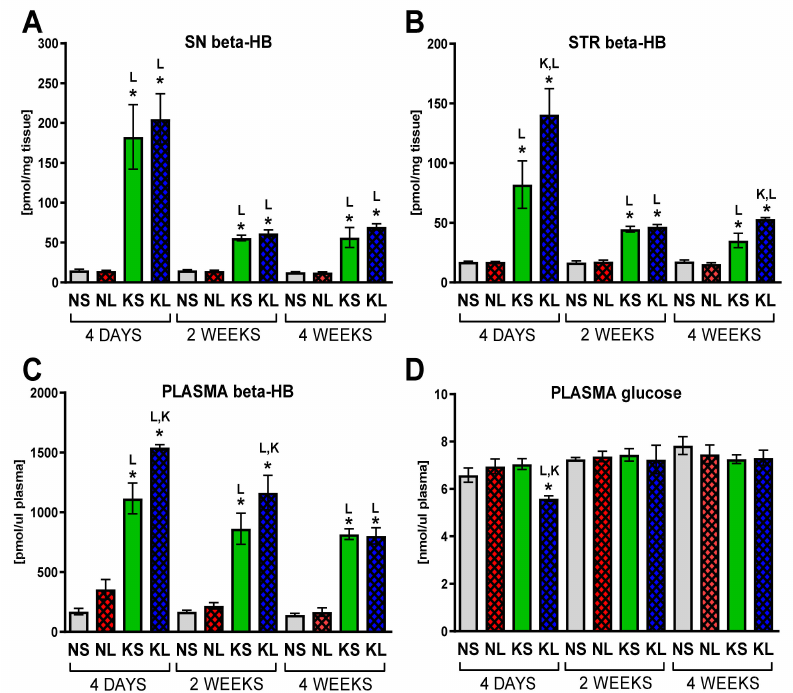
Figure 2. Ketone bodies ( A – C ) and glucose ( D ) level analysis. Glucose was measured in plasma and b-HB in plasma and brain homogenates from dopaminergic structures SN and STR. Data are presented as mean ± SEM. Analysis was performed at time-points 4 days, 2 weeks, and 4 weeks after brain surgery. Animals were kept on ketogenic diet for 3 weeks in advance. p value ≤ 0.05 was set as significance threshold and marked as * vs. normal diet + sham (NS group), L vs. normal diet + 6-OHDA lesion (NL group), K vs. ketogenic diet + sham (KS group), KL stands for ketogenic diet + 6-OHDA lesion group. Statistics: 3-way ANOVA with LSD post hoc test. Number of animals was 5–7 per